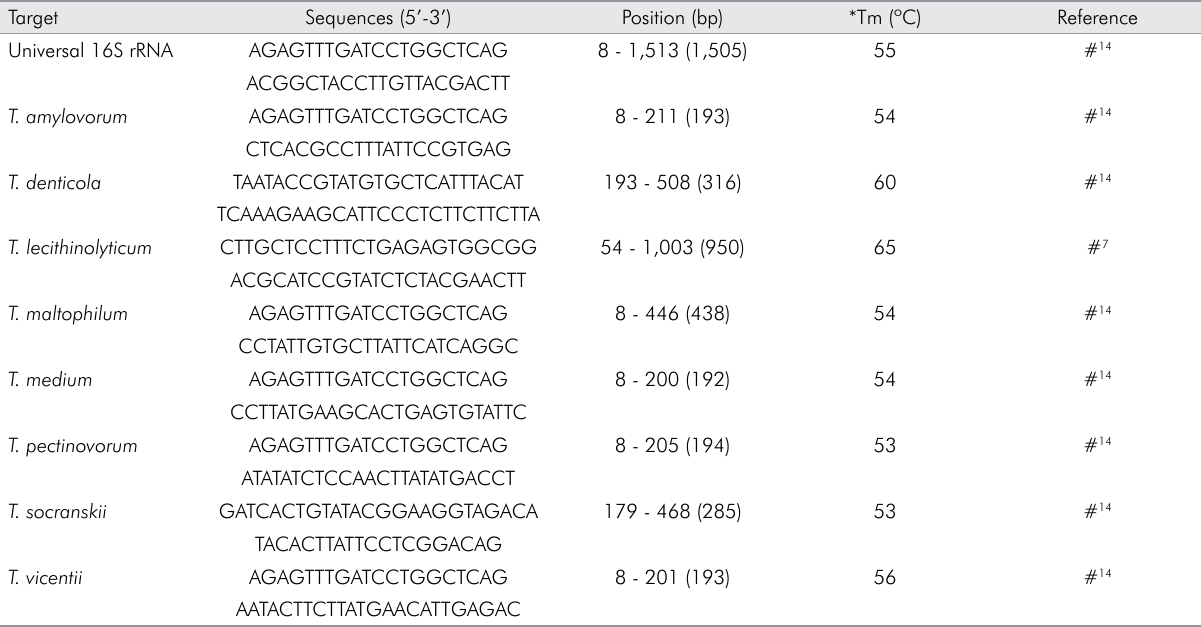
Table 1. PCR primer pairs used to detect the Treponema